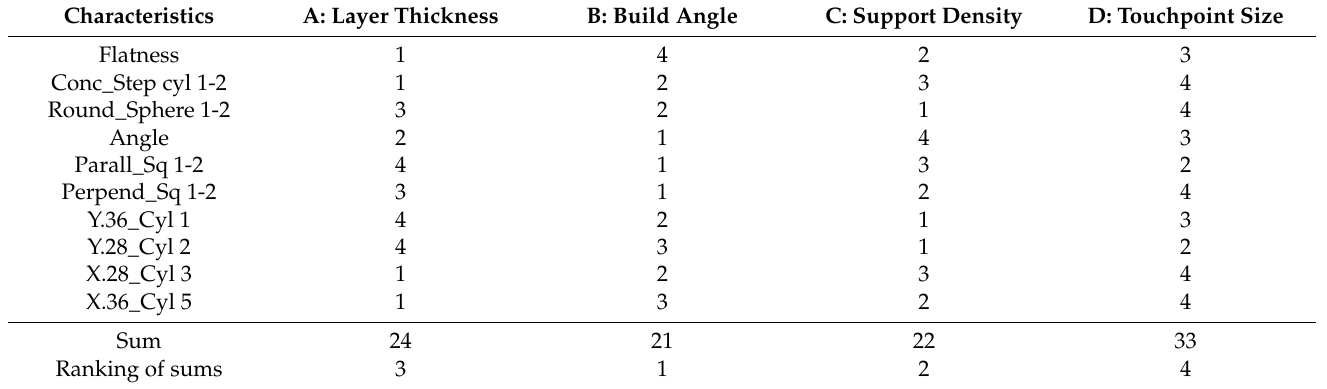
Table 13. S/N ratio ranking of parameters for geometric characteristic of